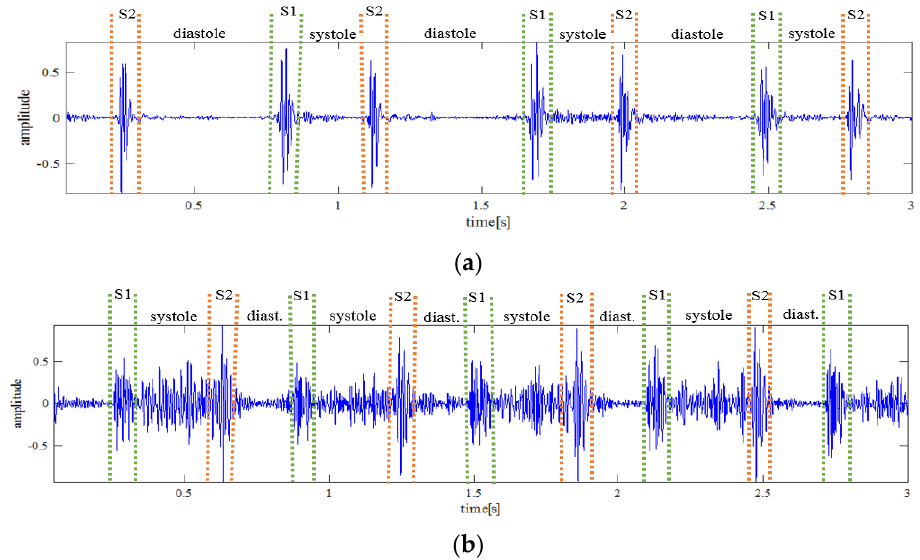
Figure 1. Graphical visualization of heart sound from: ( a ) recording from a HC with manual labeling of the fundamental heart sounds, and ( b ) recording from a PwRHD with audible murmur. Instead of manual auscultation, the World Heart Federation (WHF) has adopted echocardiographic imaging as a standard diagnostic mechanism for RHD and produced a guideline [10]. This guideline classified an echocardiogram from RHD endemic